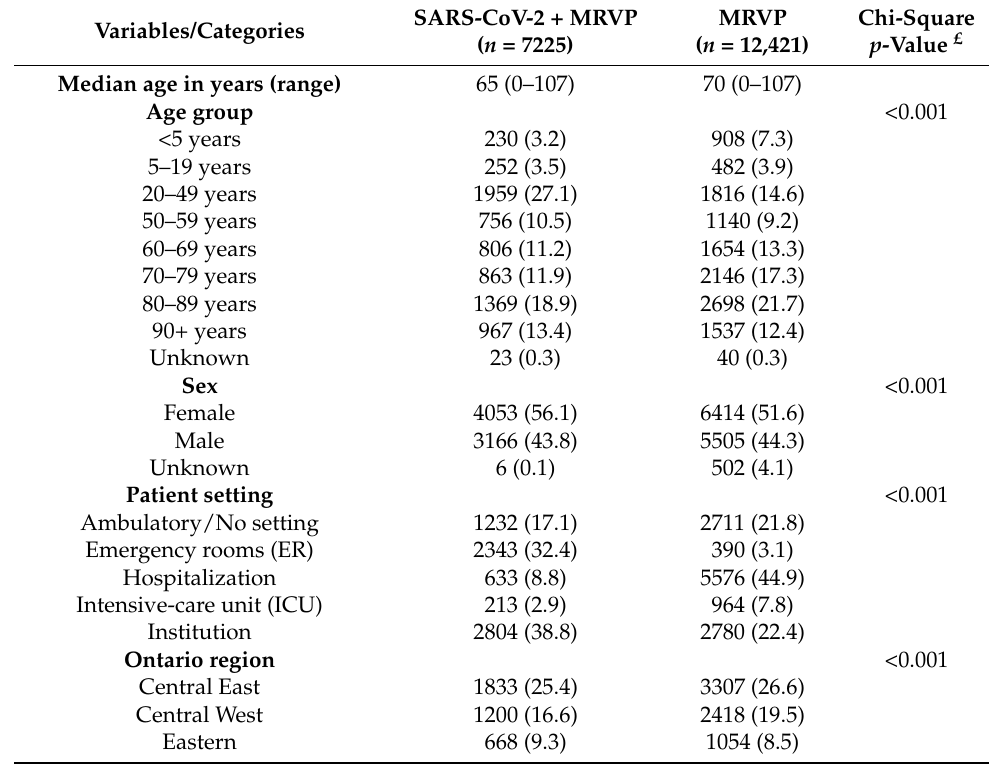
Table 1. Characteristics of patients tested for (i) severe acute respiratory syndrome coronavirus 2 (SARS-CoV-2) + MRVP (multiplex respiratory virus polymerase chain reaction) versus (ii) MRVP alone.